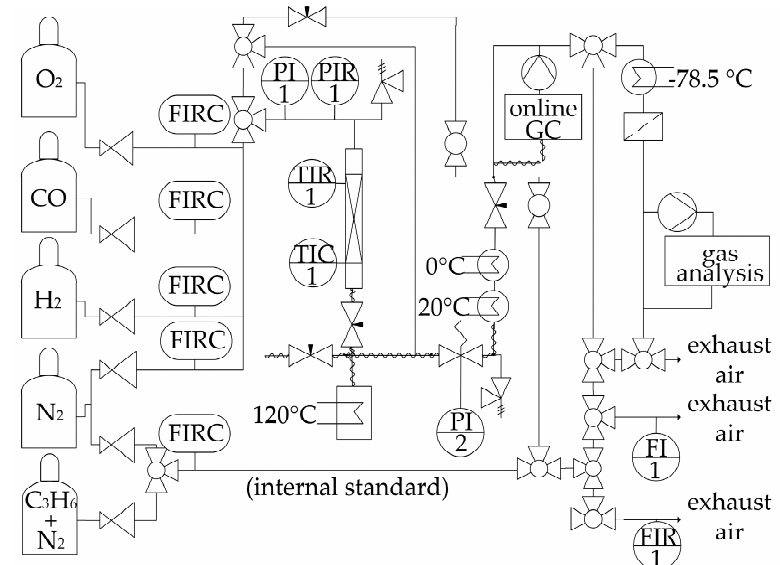
Figure 9. Setup for the FT experiments with a fixed bed reactor.